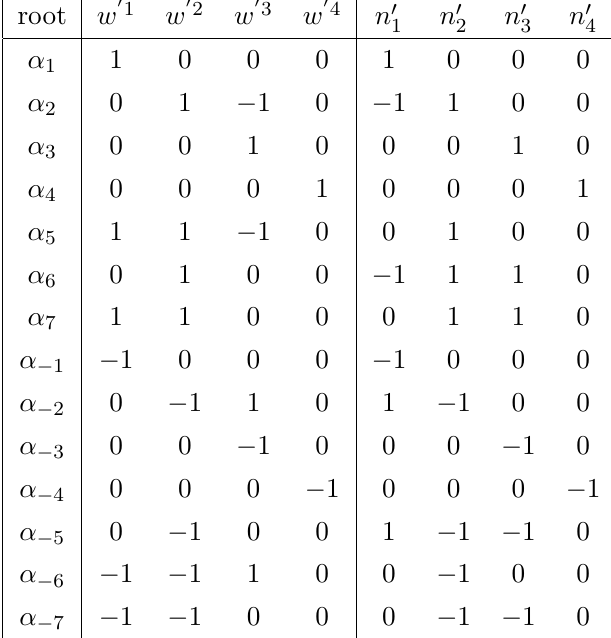
Table 12 . Momentum and winding numbers of the massless vectors at the [SU(4) (cid:2) SU(2)] L (cid:2) [SU(4) (cid:2) SU(2)] R enhancement point of T 4 , in the basis rotated by T .